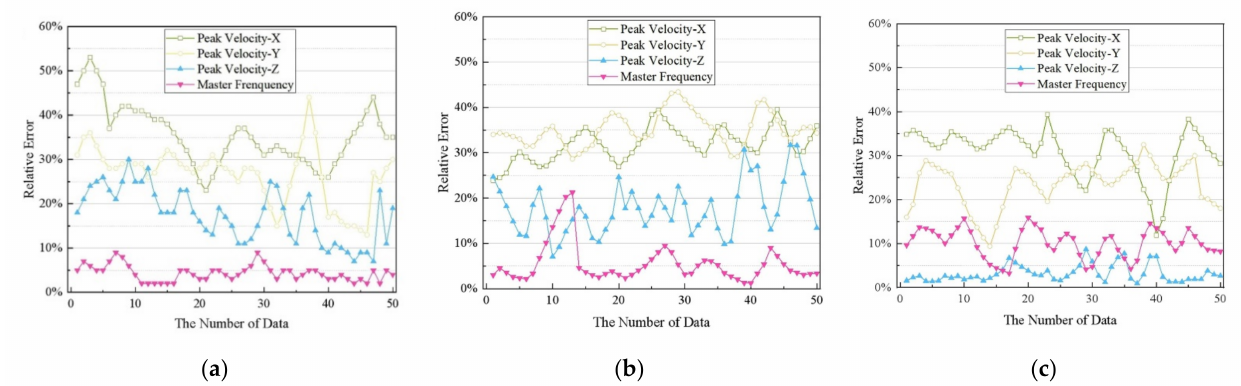
Figure 3. ( a ) Relative errors between predicted values and measured data of Model-Stratum. ( b ) Relative errors between predicted values and measured data of Model-Hollow. ( c ) Relative errors between predicted values and measured data of